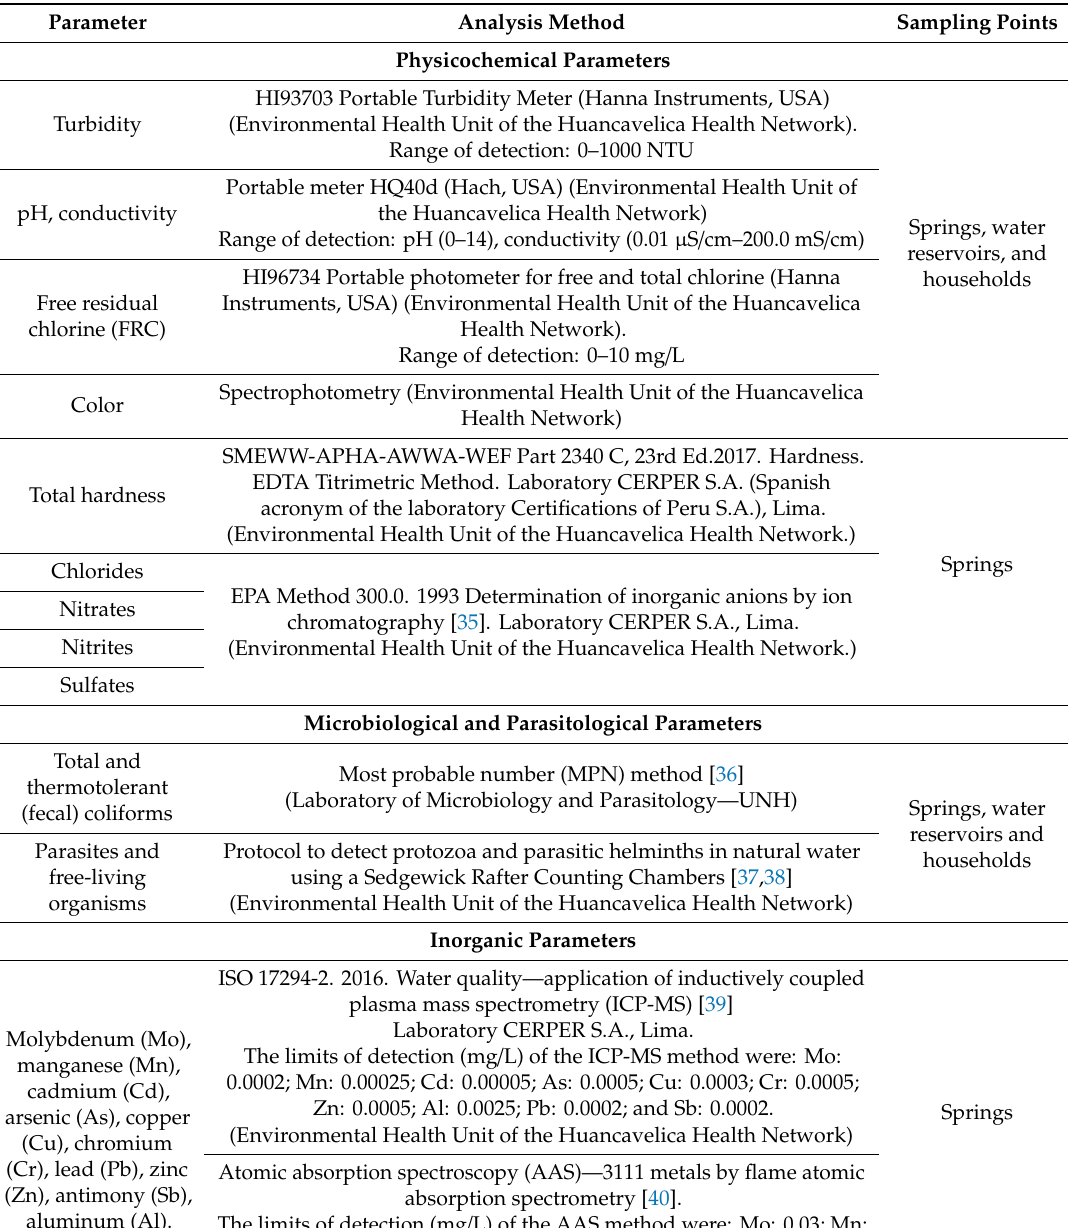
Table 2. Analysis of water quality parameters in rural